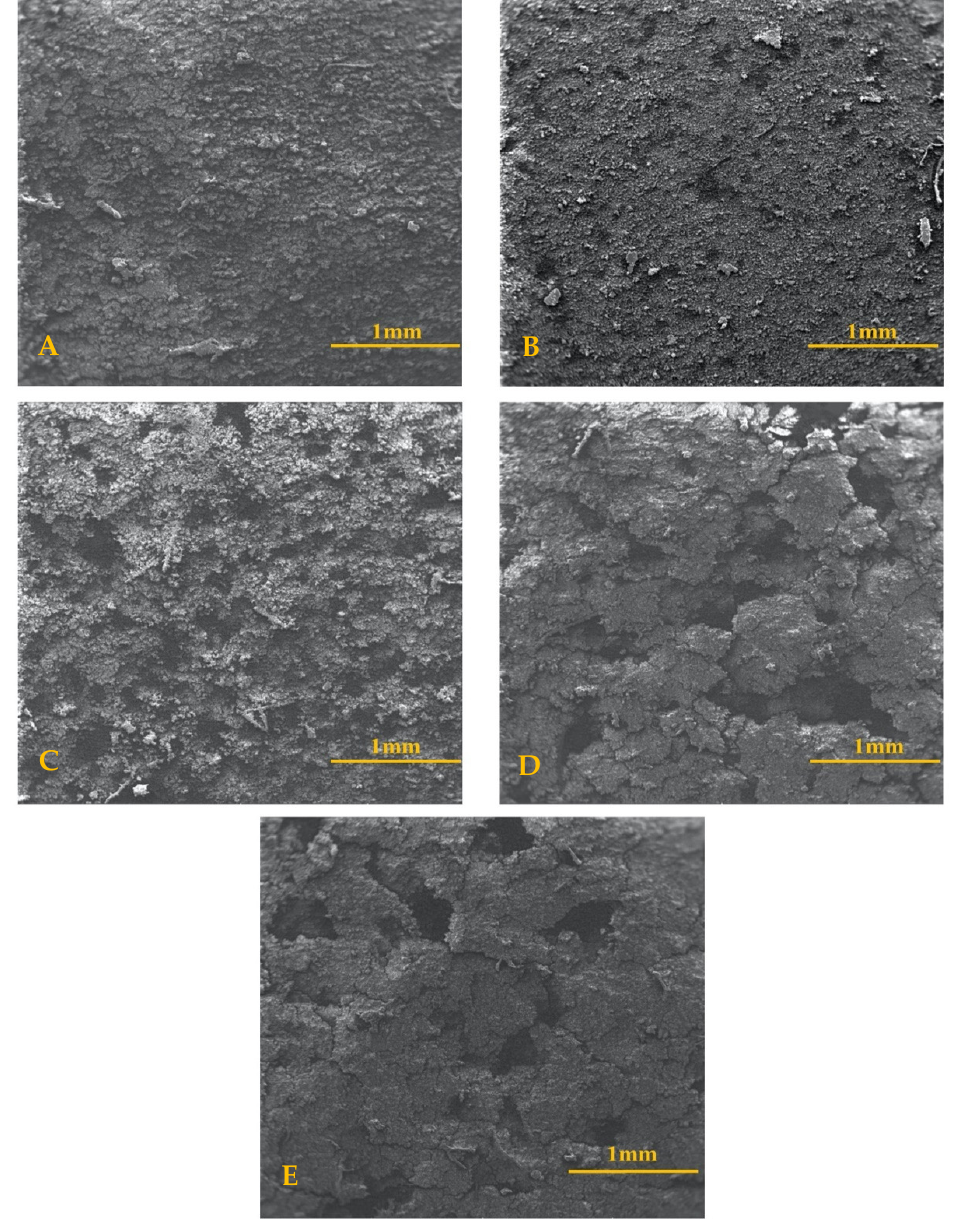
Figure 2. SEM of HA Formation Comparisons (1 mm scale). Scanning electron microscopy images taken at a field view of 3.40–3.50 mm with a 1 mm scale for ( A ) control, ( B ) sodium hydroxide, ( C ) quaternized titanium nitride, ( D ) silicon dioxide, ( E ) titanium